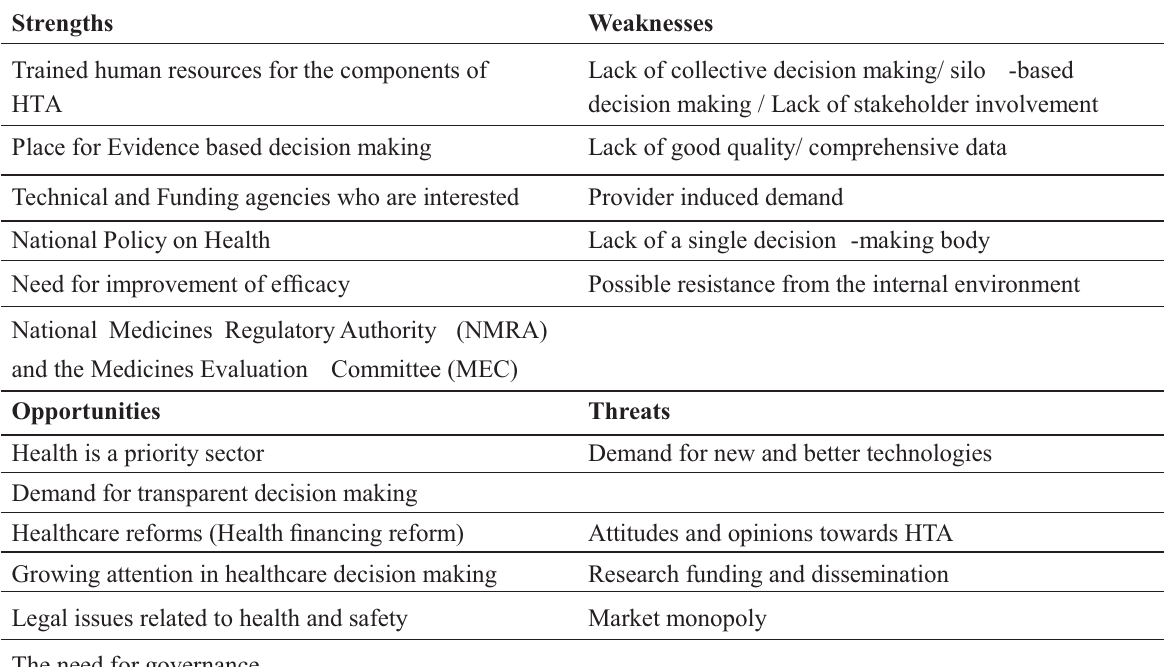
Table 1: SWOT analysis for the implementation of HTA in Sri Lanka